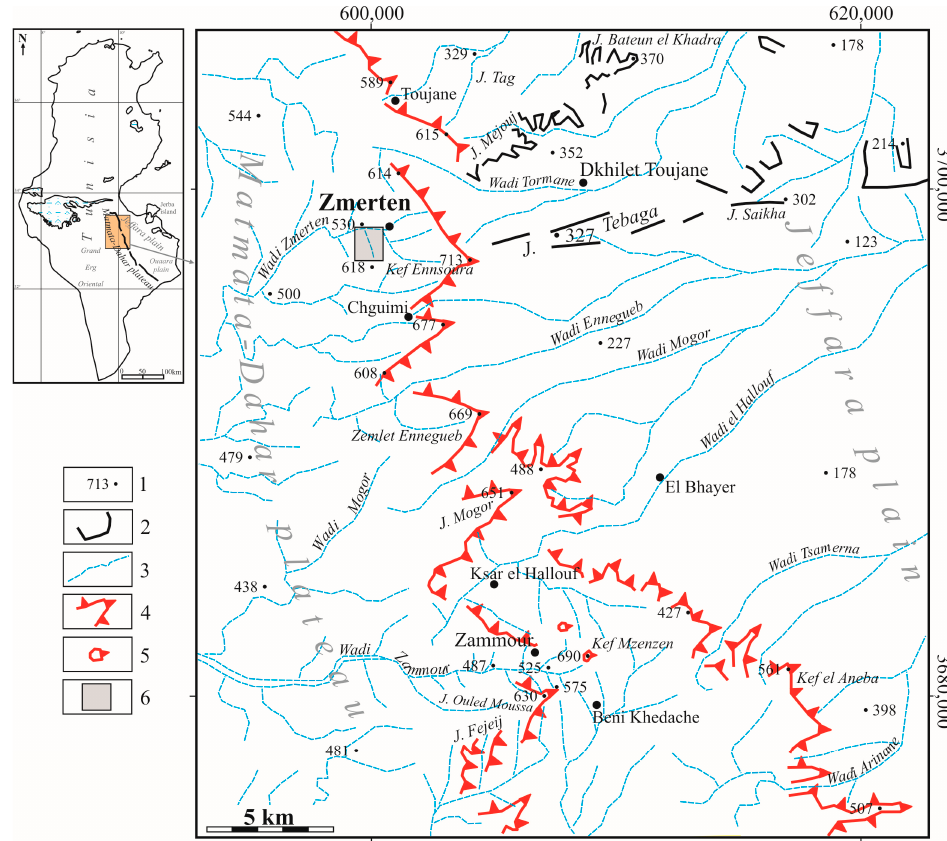
Figure 1. Location and general geomorphological context of the study area (Zmerten) on the Matmata-Dahar plateau (southeast Tunisia). 1. Altitude, 2. Talus, 3. Wadi (intermittent stream), 4. Cuesta, 5. Witness butte, 6. Studied site.